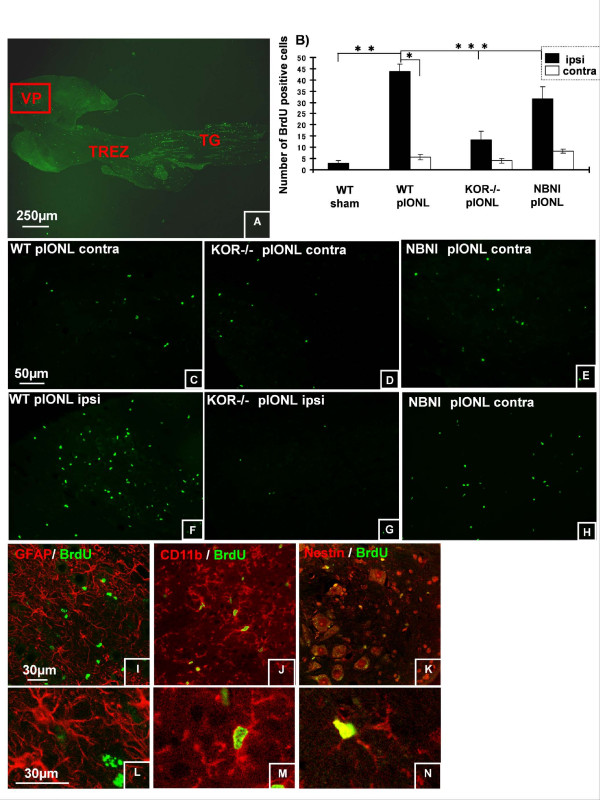
Cell proliferation central trigeminal root at day 8 after pIONL. (A) Data came from Vp (the area shown in red box). (B, C, F), BrdU positive cells are markedly increased in the ipsilateral Vp inWT pIONL compare to contralateral side. (B-H), in KOR-/- and NBNI pre-treated pIONL mice, the number of BrdU positive cells significantly decreased compared to WT pIONL mice. (I-N), Different cellular markers (GFAP for satellite cells, CD11b for microglia, nestin for neuronal stem cell) were used to identify the phenotypes of dividing cells. The majority of BrdU positive cells were double labeled with nestin and CD11b. Only few BrdU positive nuclei were double labeled with GFAP. (*p < 0.001) Scale bars: A, 250 μm, C-H, 50 μm, I-N, 30 μm.